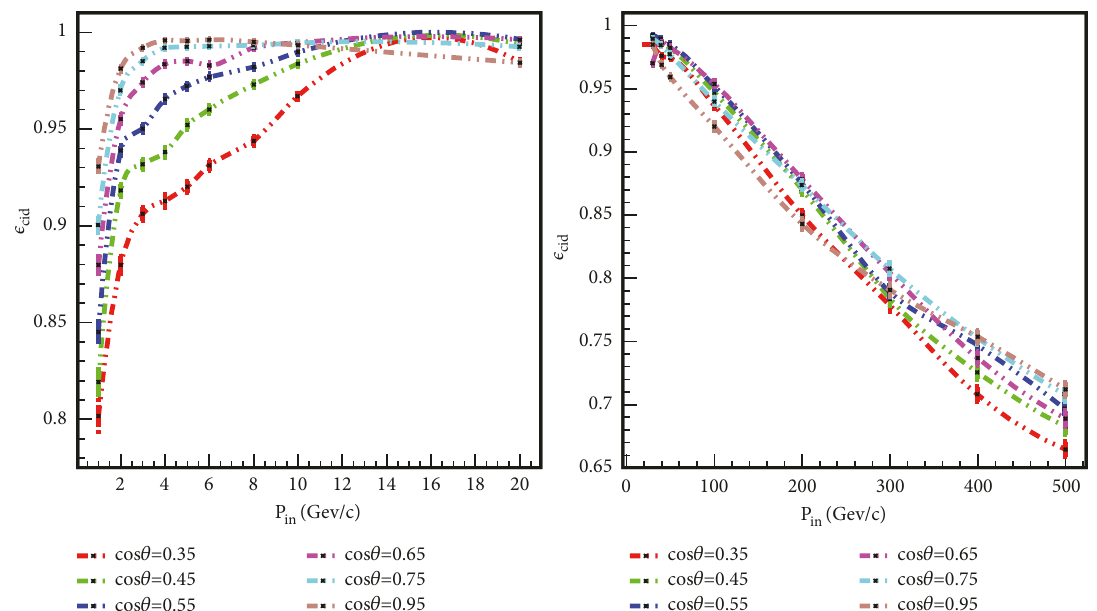
Figure 7: The relative charge identification efficiency as a function of the input muon momentum for different cos 𝜃 values. The left panel refers to low energy, 1 ≤ P 𝑖𝑛 ≤ 20 GeV muons while the right panel refers to the high energy, 20 ≤ P 𝑖𝑛 ≤ 500 GeV muons.